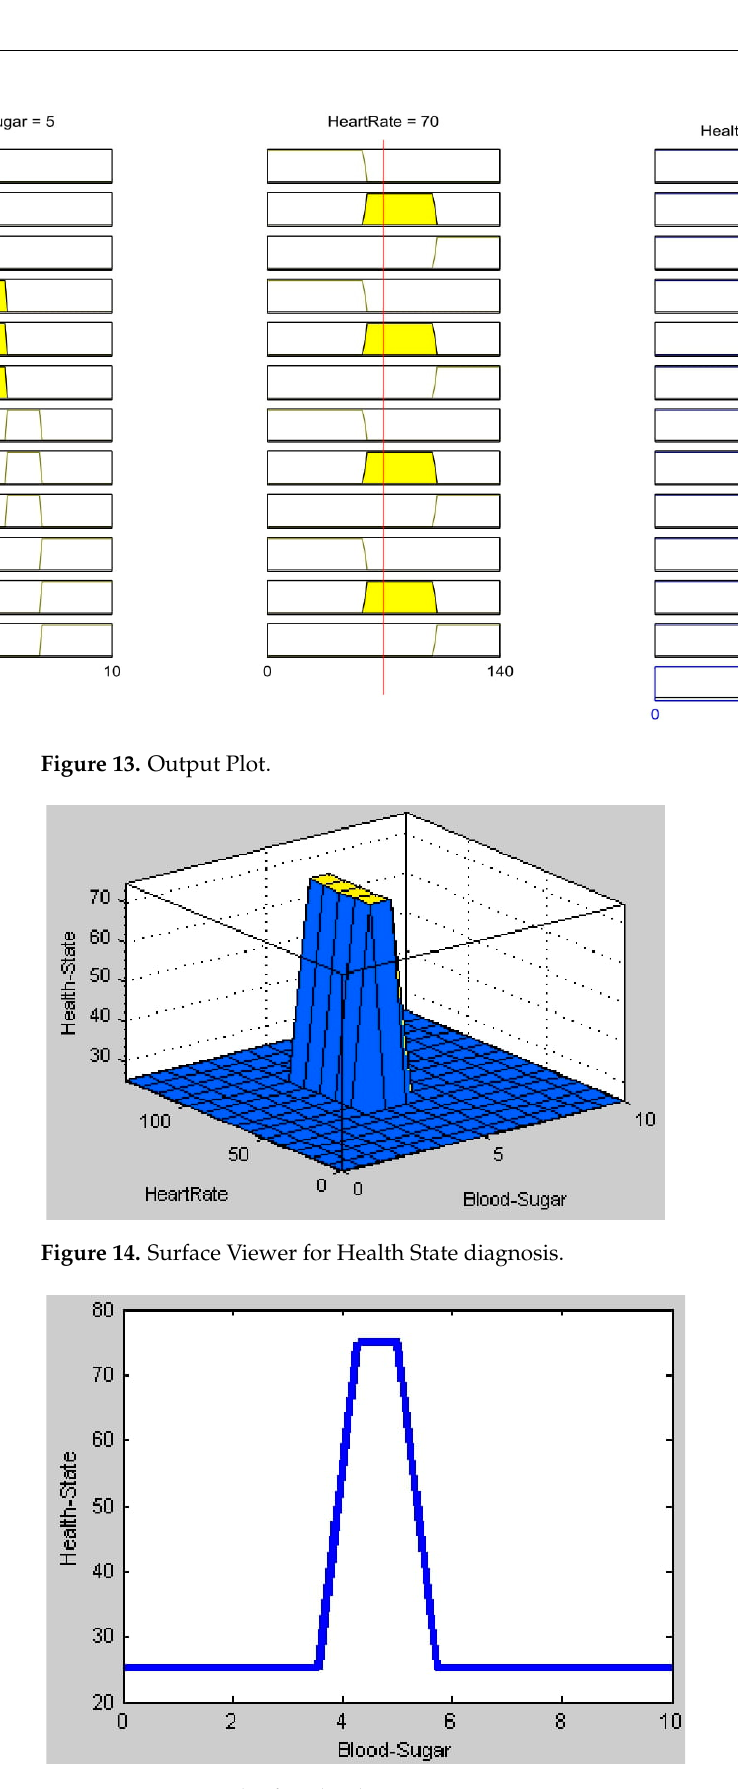
Figure 16. Output plot for Heart rate input. The fuzzy logic system for insulin calculation considers four inputs: the person’s health, diabetes level, weight, and carbohydrate intake. According to the input values in Figure 17, the health state is unhealthy (26.5), the diabetic level is medium (8.65 mmol/L), the weight is moderate (71.6 kg), and the carbohydrate intake is medium (260 g). Accord- ing to the rules in Table 3, the centroid method of calculation indicates that the calculated